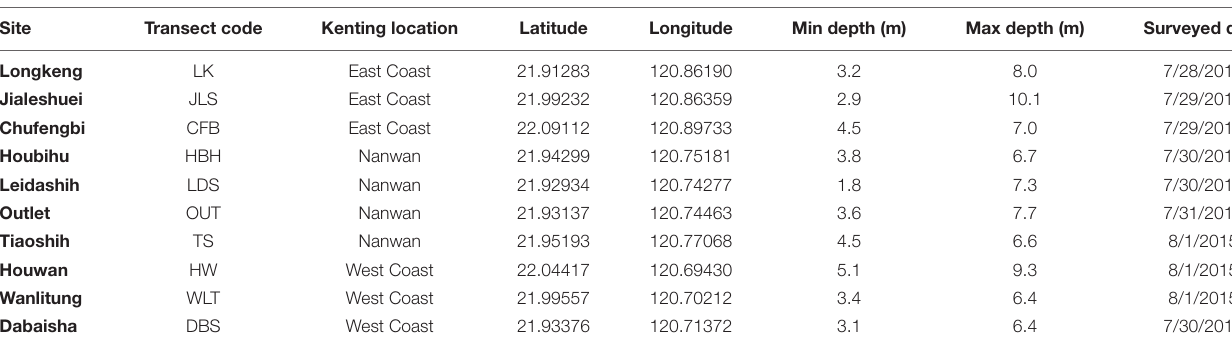
FIGURE 2 | Study area. Green line represents the limits of KNP, while red dots represent surveyed sites. TABLE 1 | Information on the locations